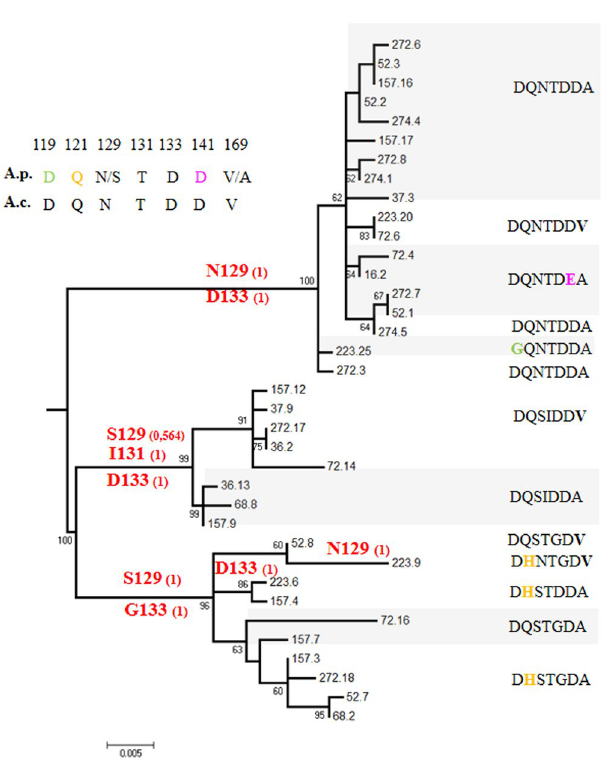
Figure 4. Ancestral reconstruction of polymorphic amino-acid replacements in the BRICHOS domain and the mature AMP in Alvinella pompejana (Ap) using the aaML package of PaML4.0 and Alvinella caudata (Ac) as an outgroup to orientate mutations. Positions of amino-acid replacements are labeled according to the start (methionine) codon. The Bayesian probability of occurrence of an amino-acid in the ancestral sequence is given in brackets. The tree topology and associated bootstrap values (obtained from 1000 replicates) was obtained by the ML method in Mega 5.0 using the full sequences of the 3 ′ region of the gene. Sequence labels represent the individual number and the clone number and are representative of the 6 paralogous clades (excluding natural recombinants) and subsequently used in the mapping of the BRICHOS mutations (see BRICHOS amino-acid alignment in Fig.